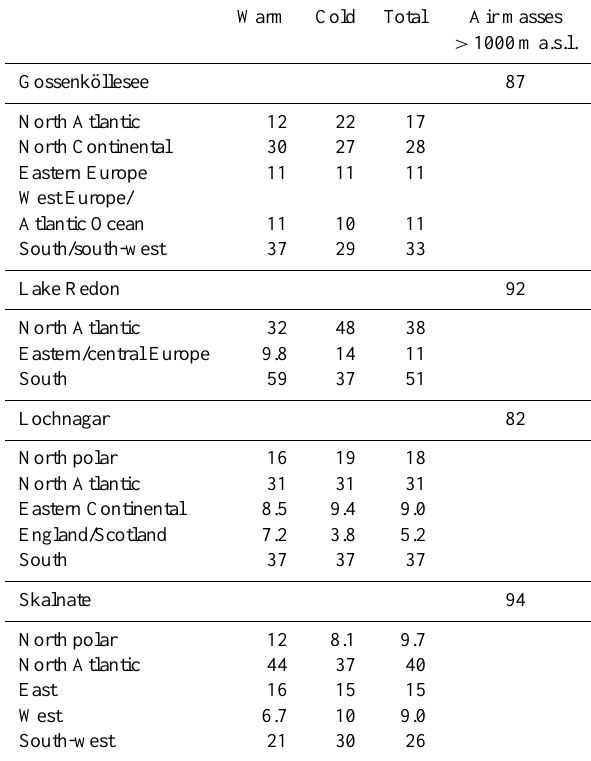
Table 2. Percent contributions of air mass trajectories to the studied sites. Warm Cold Total Air masses >